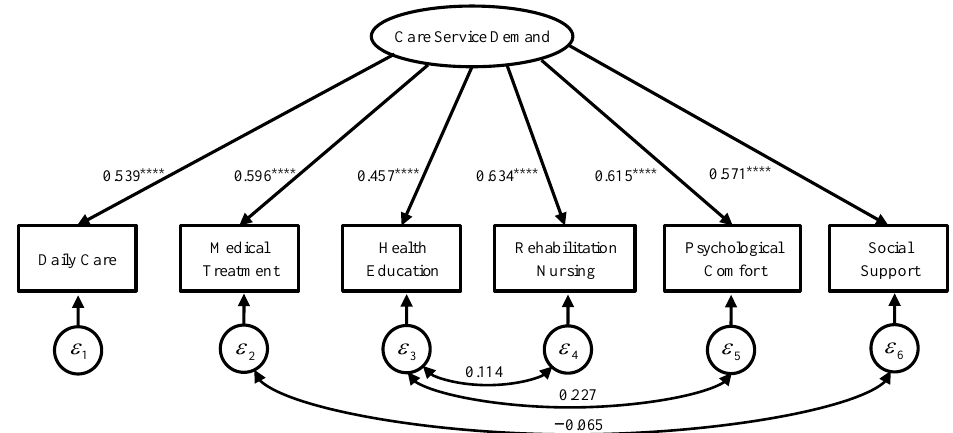
Figure 4. Confirmatory factor analysis of care service needs. Note: the estimation method is resampling method (bootstrap 1000 times), report the standardization coefficient, **** represents the significant level of 0.1%. Table 2. Calculation of urban and rural care service demand in eastern, central, and western regions. Weighted Average